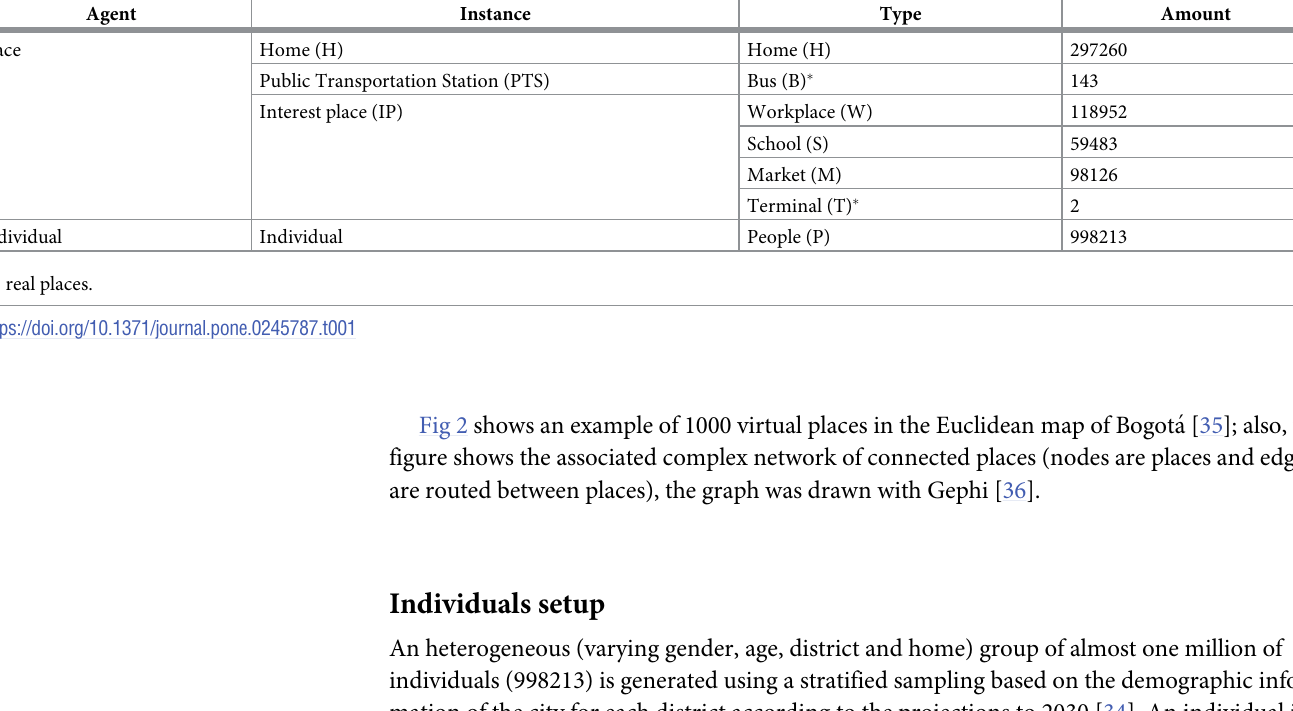
Table 1. Data used in the simulation.